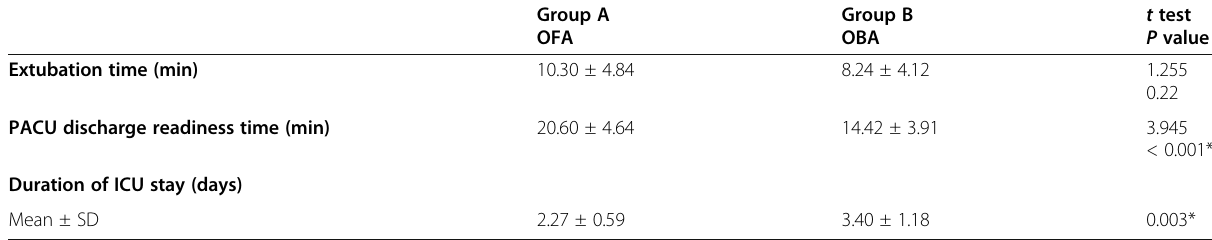
Table 5 Comparing the average extubation time, PACU discharge readiness time and duration of ICU stay (days)